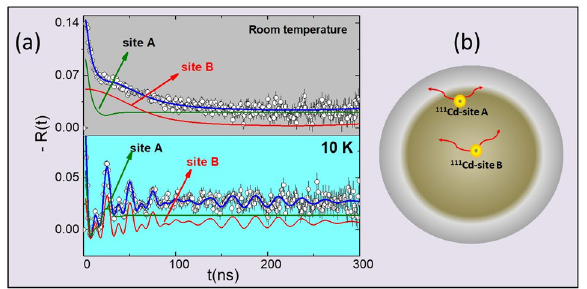
111 Cd in S2 sample at room temperature (top) and 10 111 Cd probe nuclei